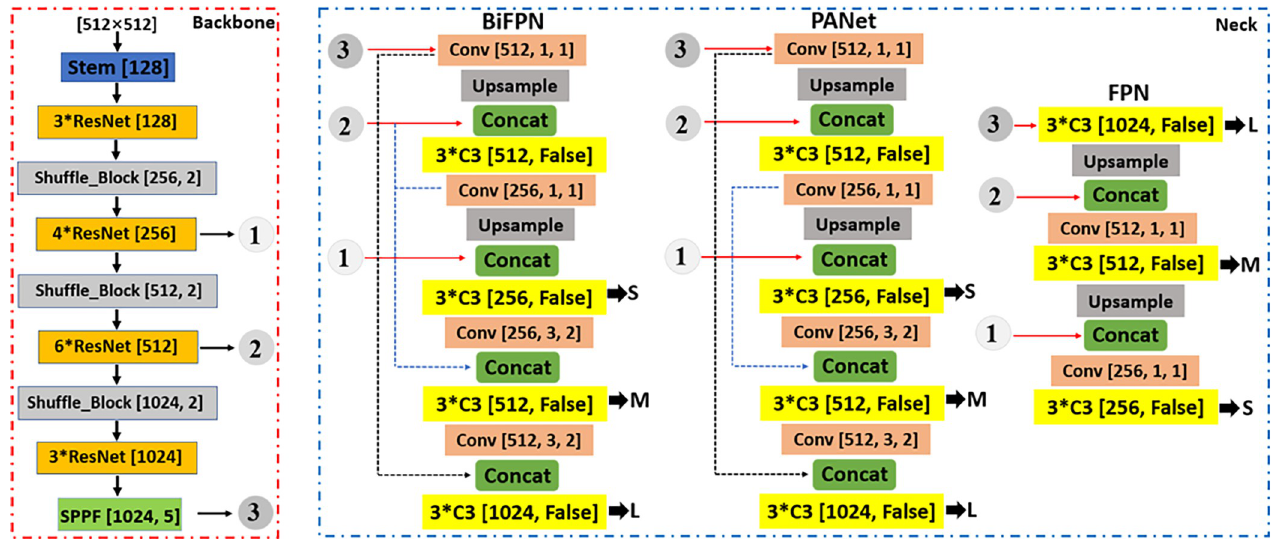
Fig 1. Network of YOLOv5-LiNet. LiNet backbone including neck of BiFPN, PANet and FPN.